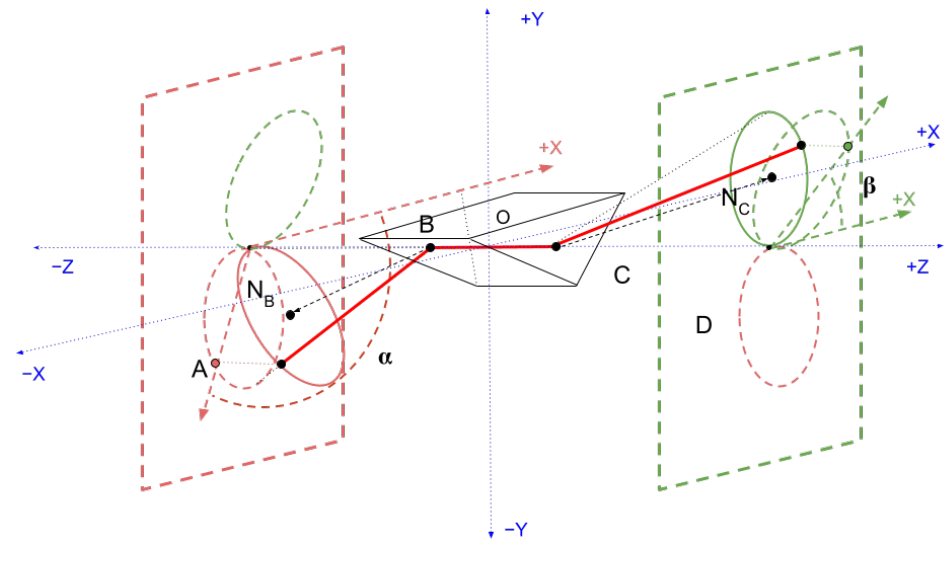
Figure 8. Equal face angle